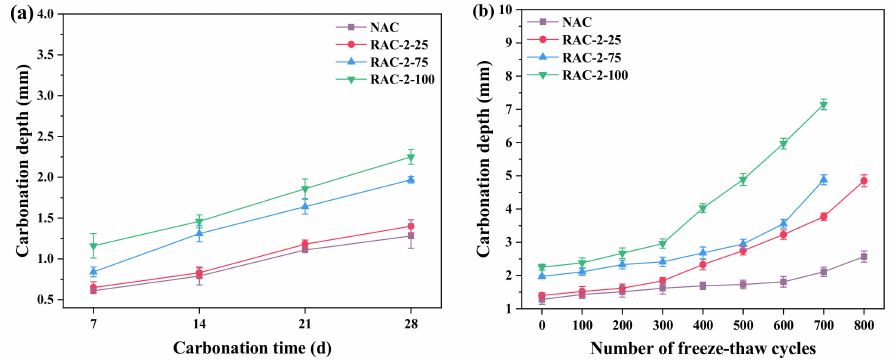
Figure 7. Carbonation depth of RAC-2 with different replacement rates ( a ) before and ( b ) after freeze–thaw